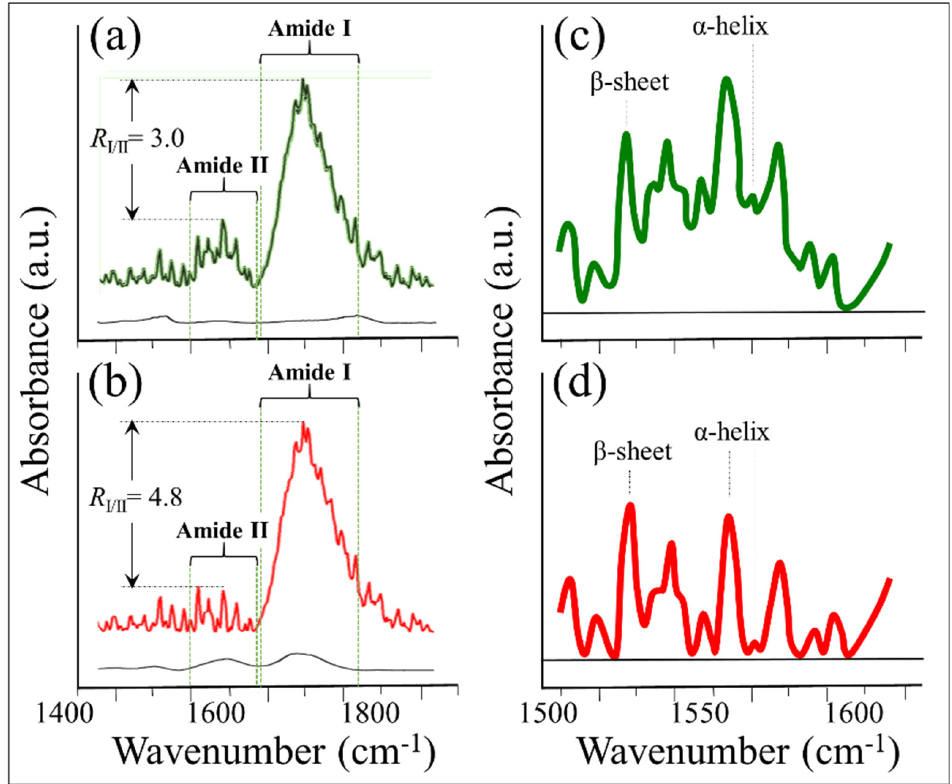
Figure 8. FTIR spectra collected in the spectral region 1400 to 1800 cm − 1 for cartilage tissue grown on ( a ) NanoCliP-FD gel and ( b ) atelocollagen scaffolds. In ( c,d ), the enlarged spectral zone 1500–1600 cm − 1 of the amide II vibrations is shown as collected on cartilage samples grown onto NanoCliP-FD gel and atelocollagen scaffolds, respectively.